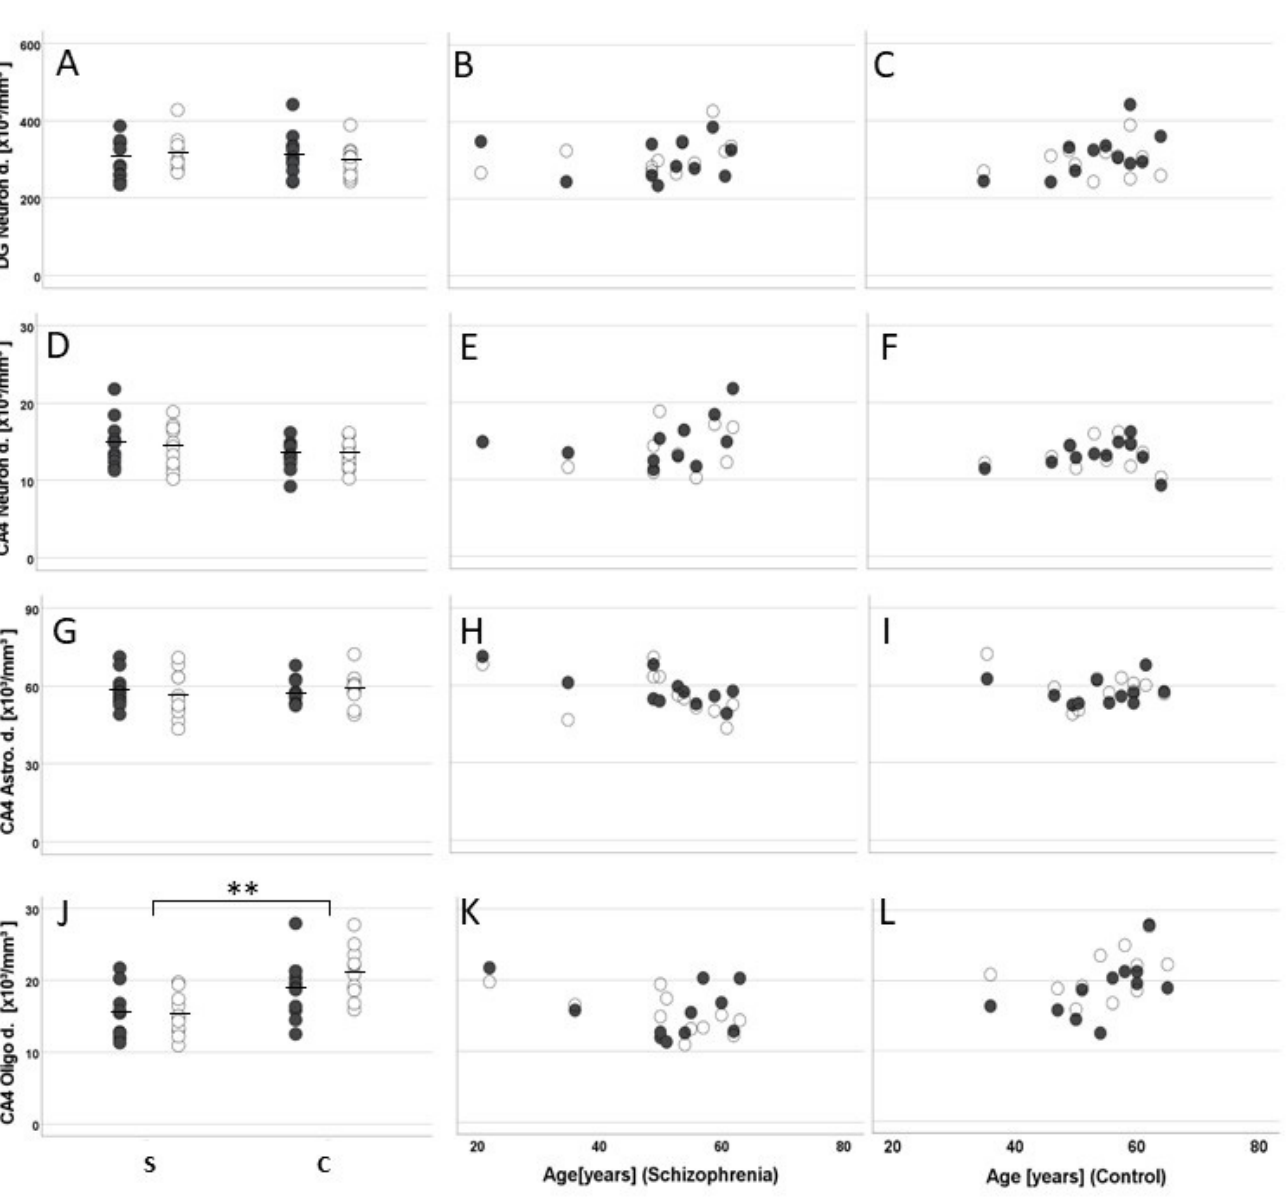
Figure 5. Mean and standard error of the mean ( A , D , G , J ) and individual values correlated with age (patients with schizophrenia [S]: ( B , E , H , K ); controls [C]: ( C , F , I , L )) of the density of neurons (in 10 3 /mm 3 ) in the hippocampal granule cell layer (the dentate gyrus; DG Neuron d.; ( A – C )) and cornu ammonis 4 (CA4 Neuron d.; ( D – F )) and of the density of astrocytes (CA4 Astro d.; ( G – I )) and oligodendrocytes (CA4 Oligo d.; ( J – L )) in postmortem brains from men with schizophrenia and age- and sex-matched controls. Closed dots represent data from left hemispheres, and open dots, data from right hemispheres. ** p < 0.005.